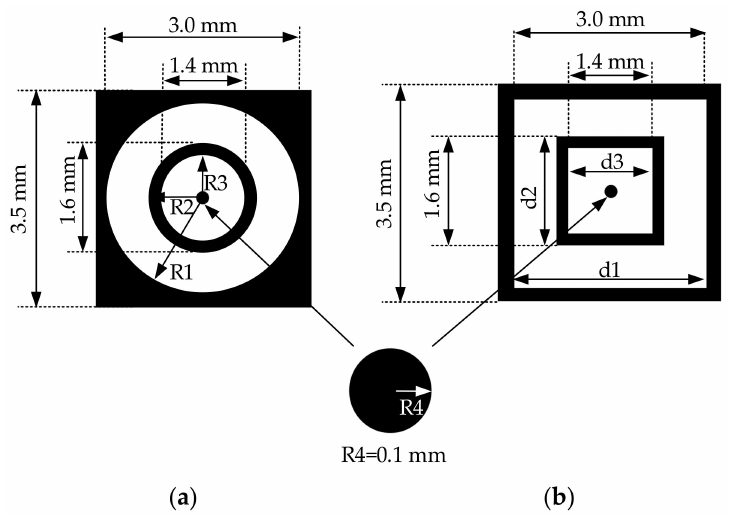
Figure 2. Comparison of the new circle electrode of tactile sensor and the square electrode: ( a ) A circle electrode; ( b ) A square